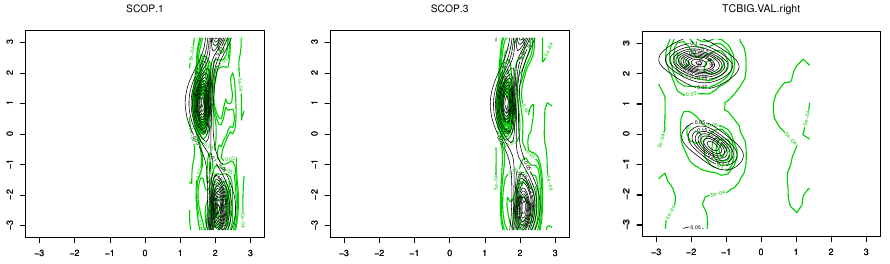
Figure 12. Kernel density plots of the data, and the best-fit